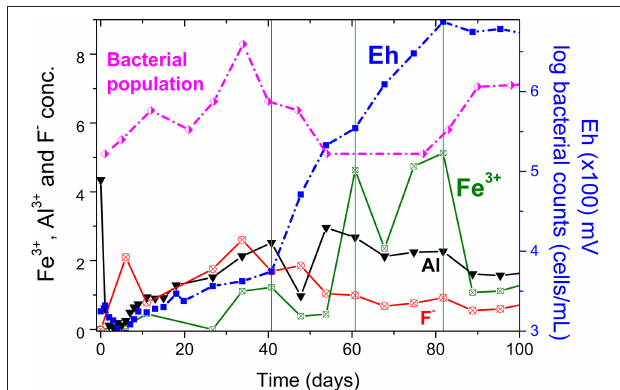
FIGURE 5 | Metal and Eh profiles in the first 100 days of experiment for the reference column (high-grade ore). The vertical lines indicate solution bleeding. Experiments with S. thermosulfidooxidans growing in Norris growth medium supplemented with yeast extract (0.1 g/L) and amended with 1.0 g/L Al 3 + (unless otherwise stated); at 50 ± 1 ◦ C (columns C1, C3–C6) or room temperature (column C2); crushed and agglomerated ore (½ ′′ top size); 8.6